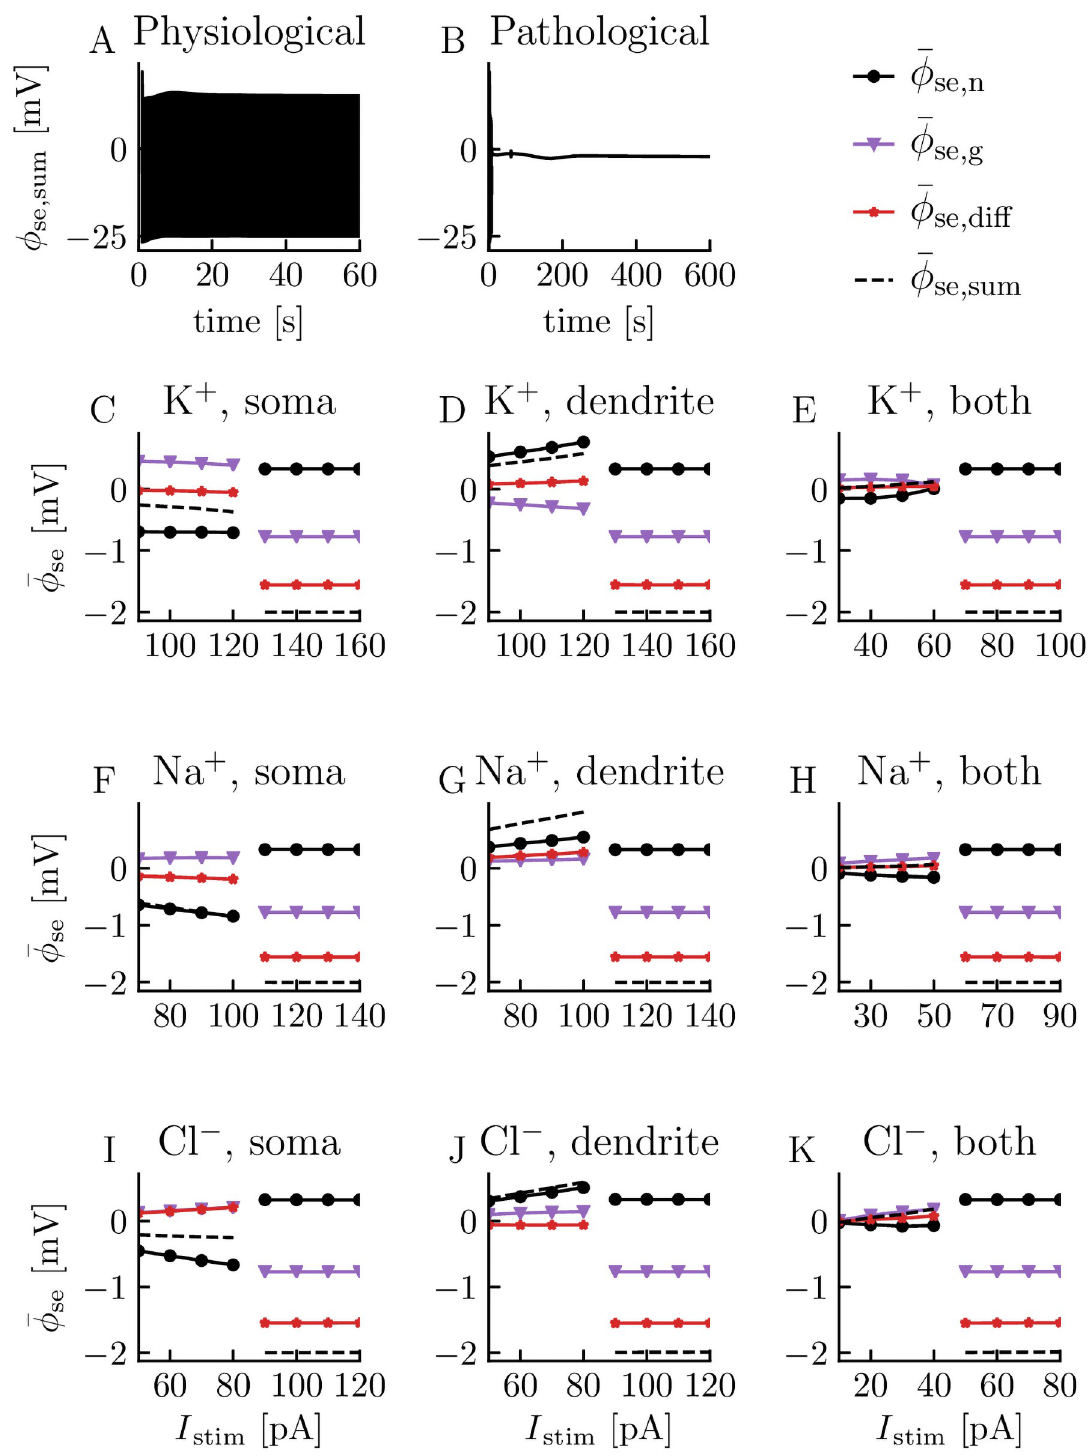
Fig 6. Effects of neurons, glia, and diffusion on slow potentials under constant current injections. ( A ) Extracellular potential during physiological steady-state firing caused by a 90 pA K + step current injection to the neuronal soma between t = 1 s and t = 60 s. Simulation ended at t = 60 s. ( B ) Extracellular potential during pathological conditions evoked by a 130 pA K + step current to the neuronal soma between t = 1 s and t = 60 s. The neuron entered depolarization block before the stimuli was turned off. Simulation ended at t = 600 s. ( C )-( K ) Extracellular slow potentials ( � ) as a function of the stimulus current I stim . � was split into se ; sum se ; sum